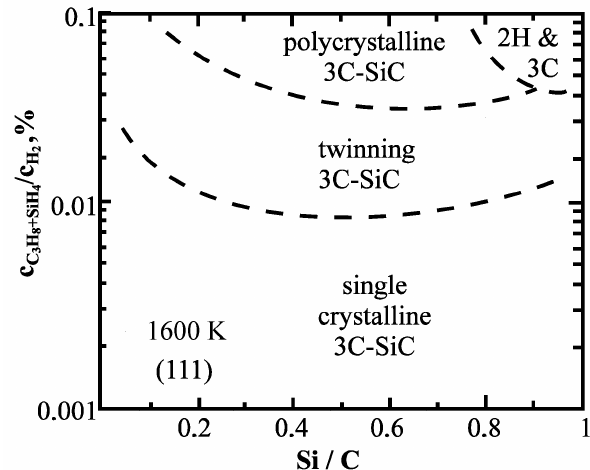
Figure 8. Phase diagram for RTCVD growth of SiC on single crystalline carbonized Si(111) at a substrate temperature of 1600 K and a linear heating up-rate of 50 K s − 1 . Growth duration of 60